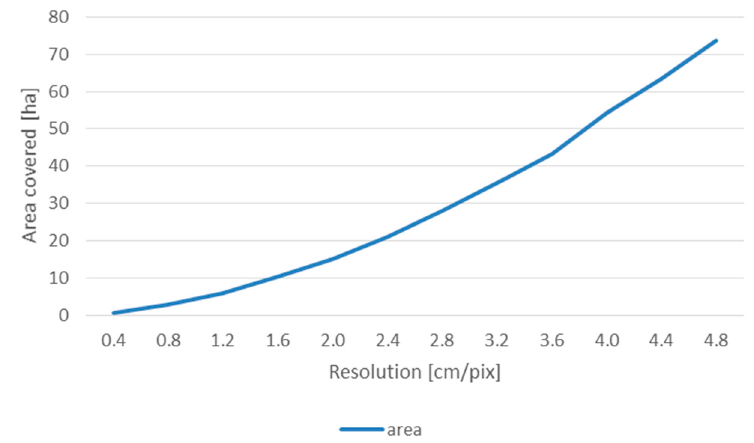
Figure 8. Differences in the extension of the detected area covered by plastic (using the classification of the 4 mm orthophoto as a reference value).